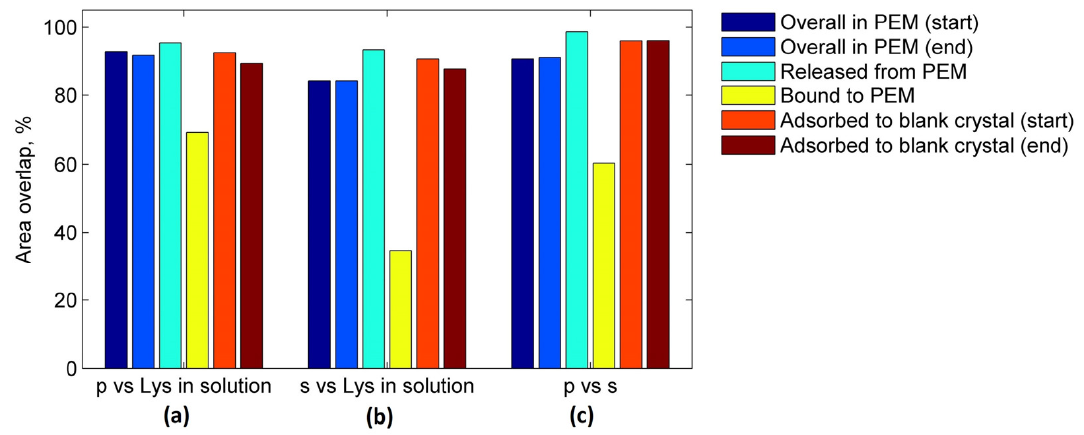
Figure 8. The bars in ( a , b ) represent area overlap values between spectra of Lys in case of the PEM- coated or blank crystal and the spectrum of Lys in solution for p and s polarizations, respectively. The bars in ( c ) represent area overlap values between spectra of Lys in case of the PEM-coated or blank crystal recorded with p and s polarizations. The cases “Overall in PEM (start) and (end)” as well as “Adsorbed to blank crystal (start) and (end)” refer to the stage of Lys adsorption (absorption spectra recorded at the beginning and at the end of the adsorption studies, respectively).